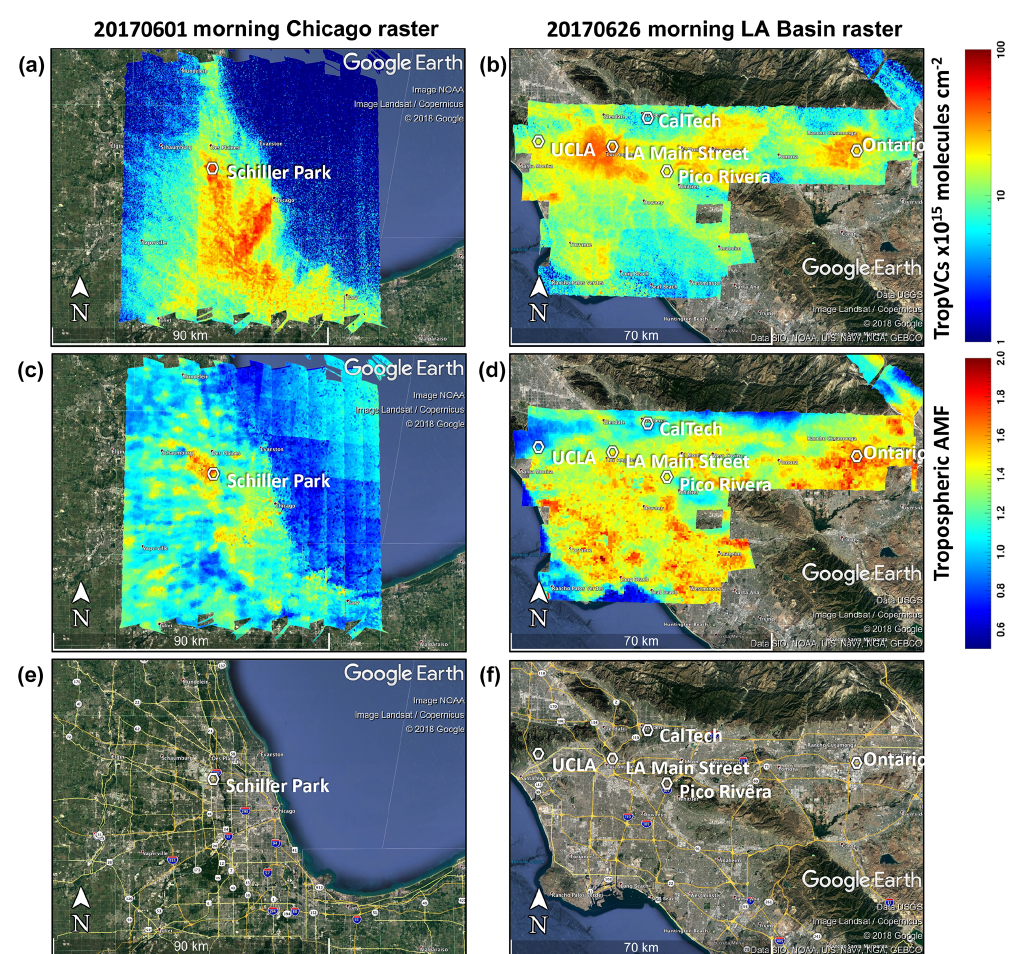
Figure 2. Tropospheric NO 2 vertical column on a log 10 color scale (a, b) , tropospheric AMF on a linear color scale (c, d) , and base map (e, f) for a Chicago raster on the morning (08:30–12:00LDT) of 1 June 2017 (a, c, e) and an LA Basin raster on the morning (08:40–10:05LDT) of 26 June 2017 (b, d, f) . The base maps show roadways, urbanized areas, and surface characteristics. The labeled hexagons indicate locations of Pandora spectrometers. Base map created in ©Google Earth